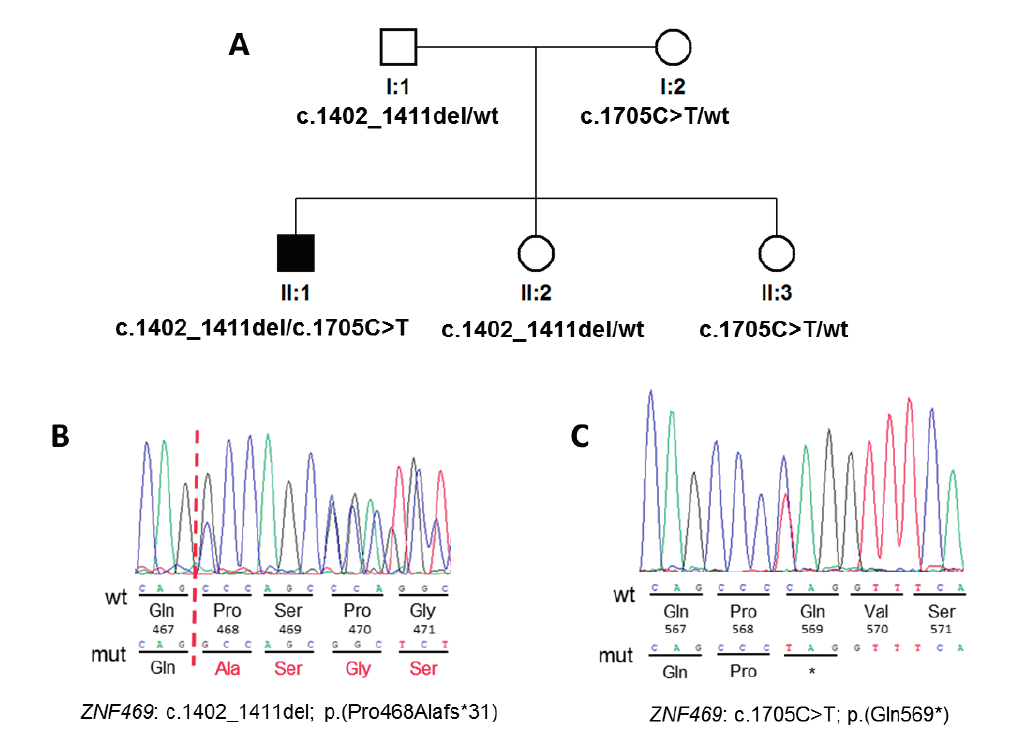
Fig. 3. Pedigree and results of molecular genetic testing. (A) Pedigree of the investigated family, sequence chromatograms of the heterozygous mutations identified in ZNF469 (B) c.1402_1411del and (C) c.1705C>T. Wild type is referred as